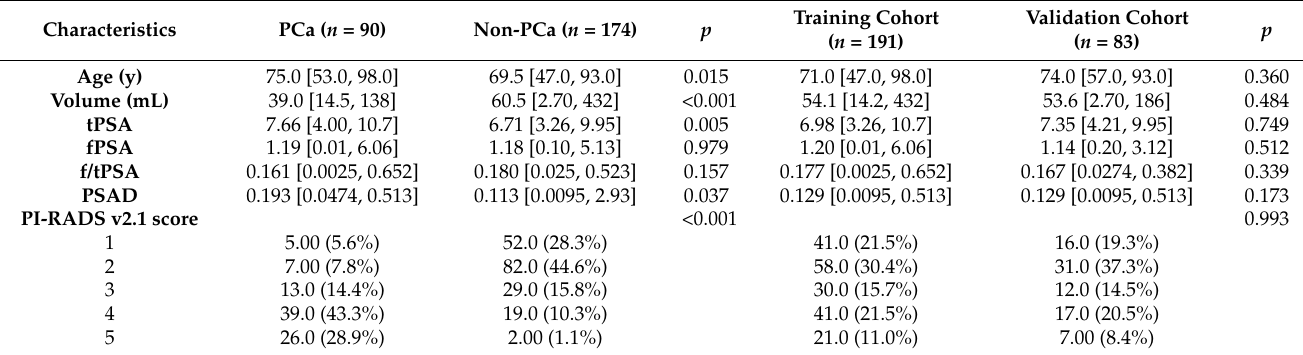
Table 1. The characteristics of all patients.